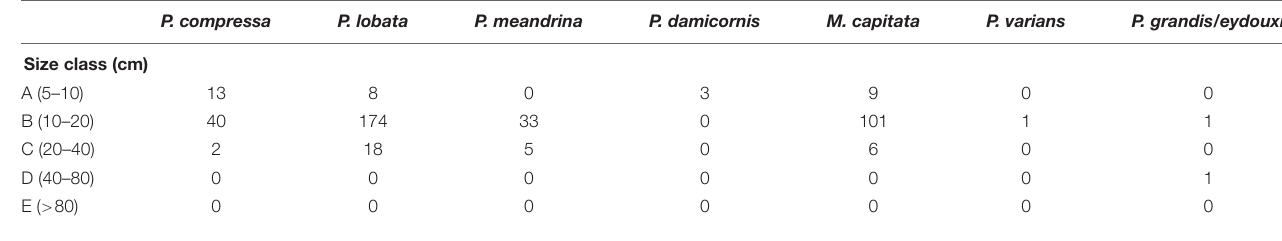
TABLE 2 | List of coral colonies attached to the